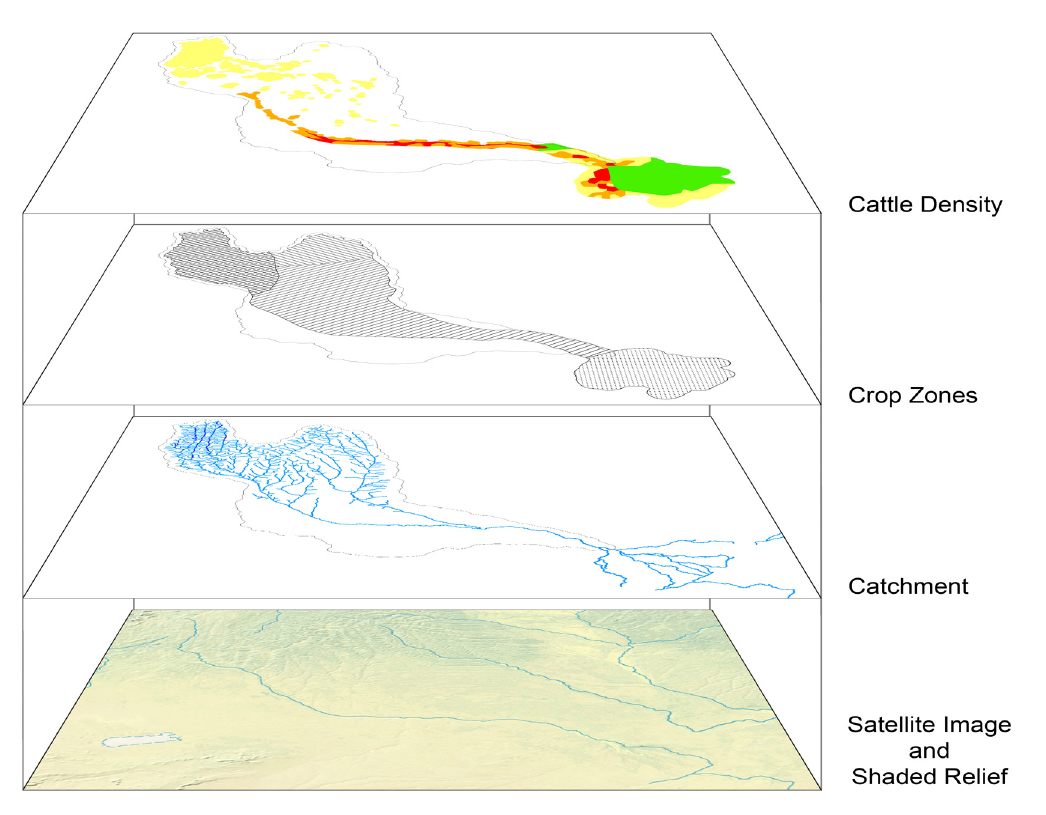
Figure 1. Compilation of panel maps (own representation based on data from